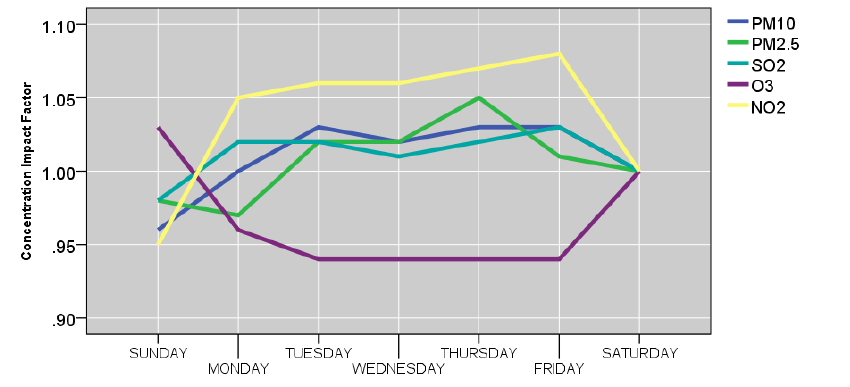
Figure 11. Weekday concentration impact